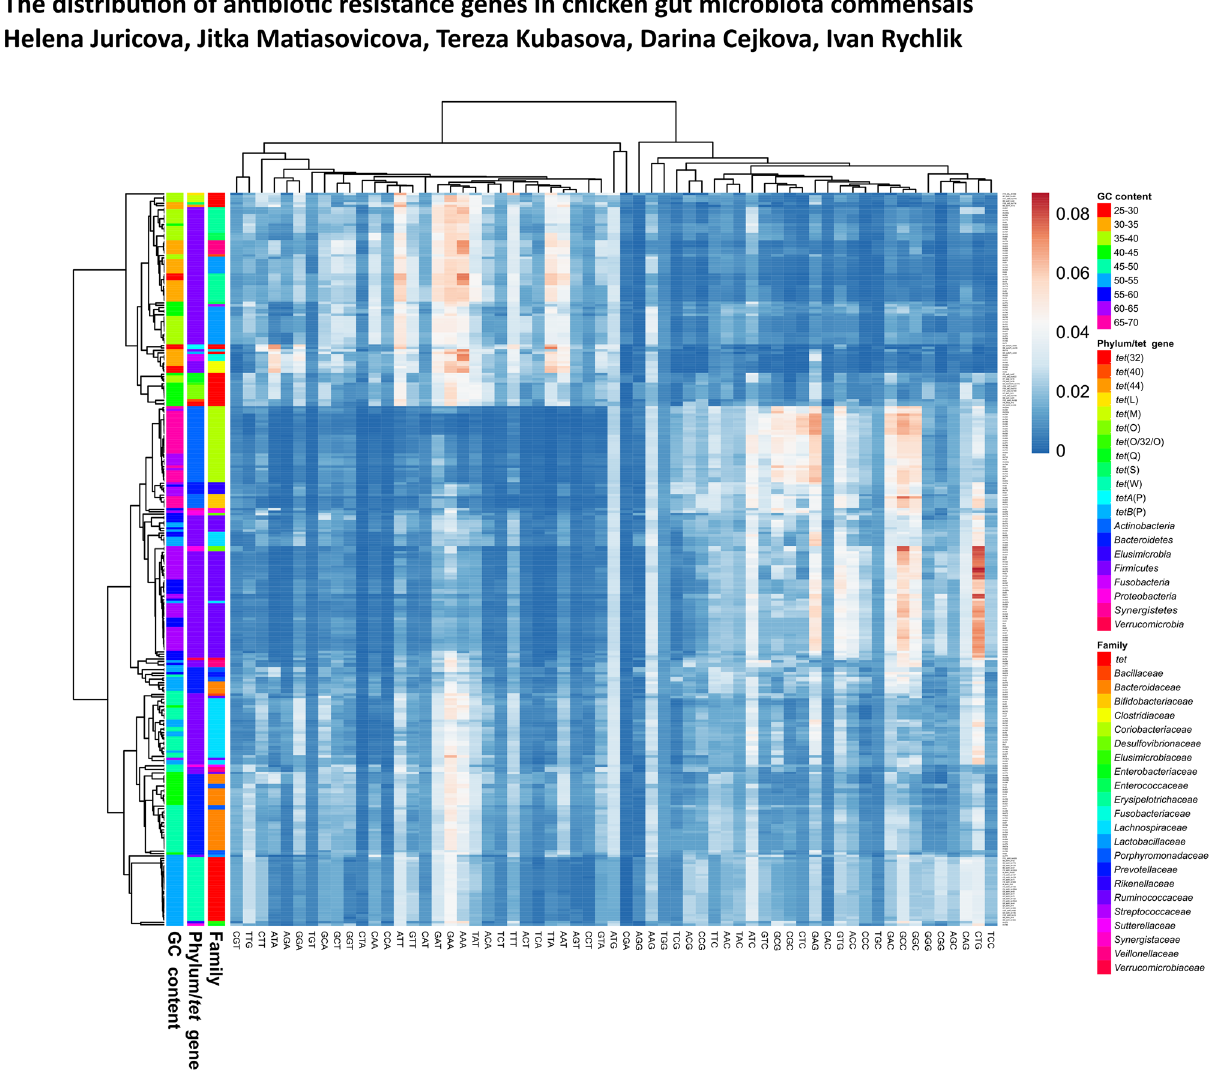
Figure 4. Clustering of all isolates analysed in this study and all tetracycline resistance genes based on GC content and codon usage. Frequency of codon usage in each of the tetracycline resistance genes and frequencies of codon usage averaged across all genes in the genomes of each of the analysed isolates were used for mutual clustering. Since tet proteins consisted of 408 to 657 amino acids, the distribution of each of the 61 codons coding for a particular amino acid could be considered as random and representative. However, since only a single stop codon may appear in each tet gene, frequency of stop codon usage was not considered. The heat map was constructed in ClustVis, https ://biit.cs.ut.ee/clust vis/ 19